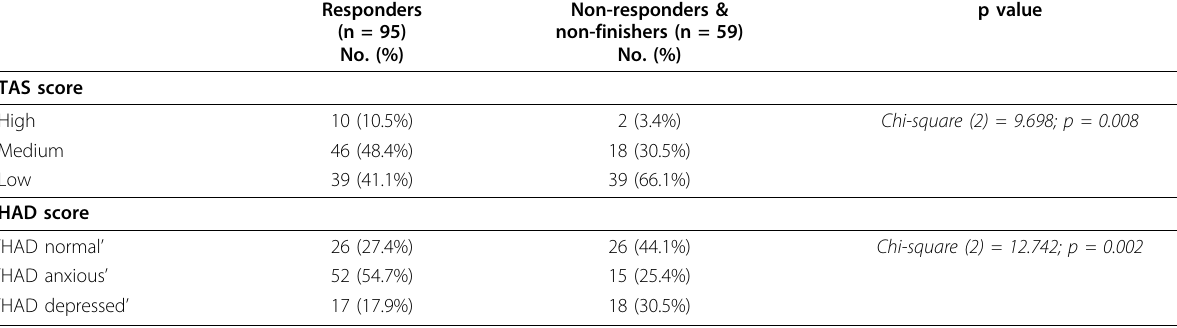
Table 8 Univariate analysis relating TAS and HAD score to response to